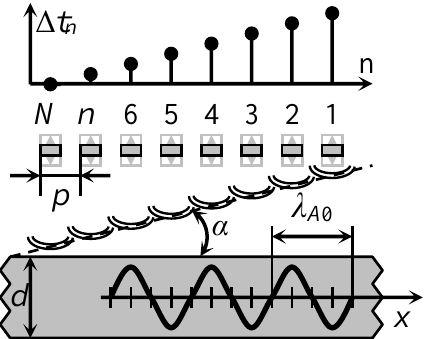
Figure 3. Air-coupled excitation of the A 0 Lamb wave mode by a phased array with rectangular elements.